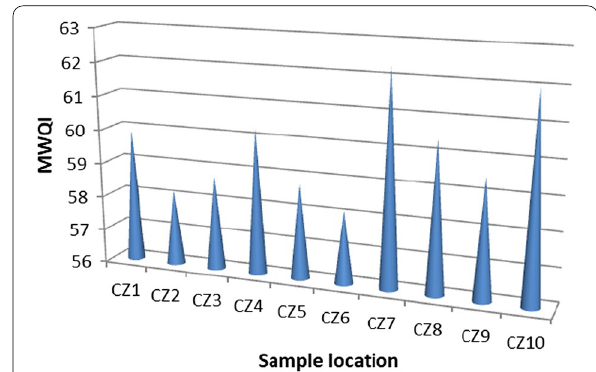
Fig. 2 Total value of the marine quality index for the different